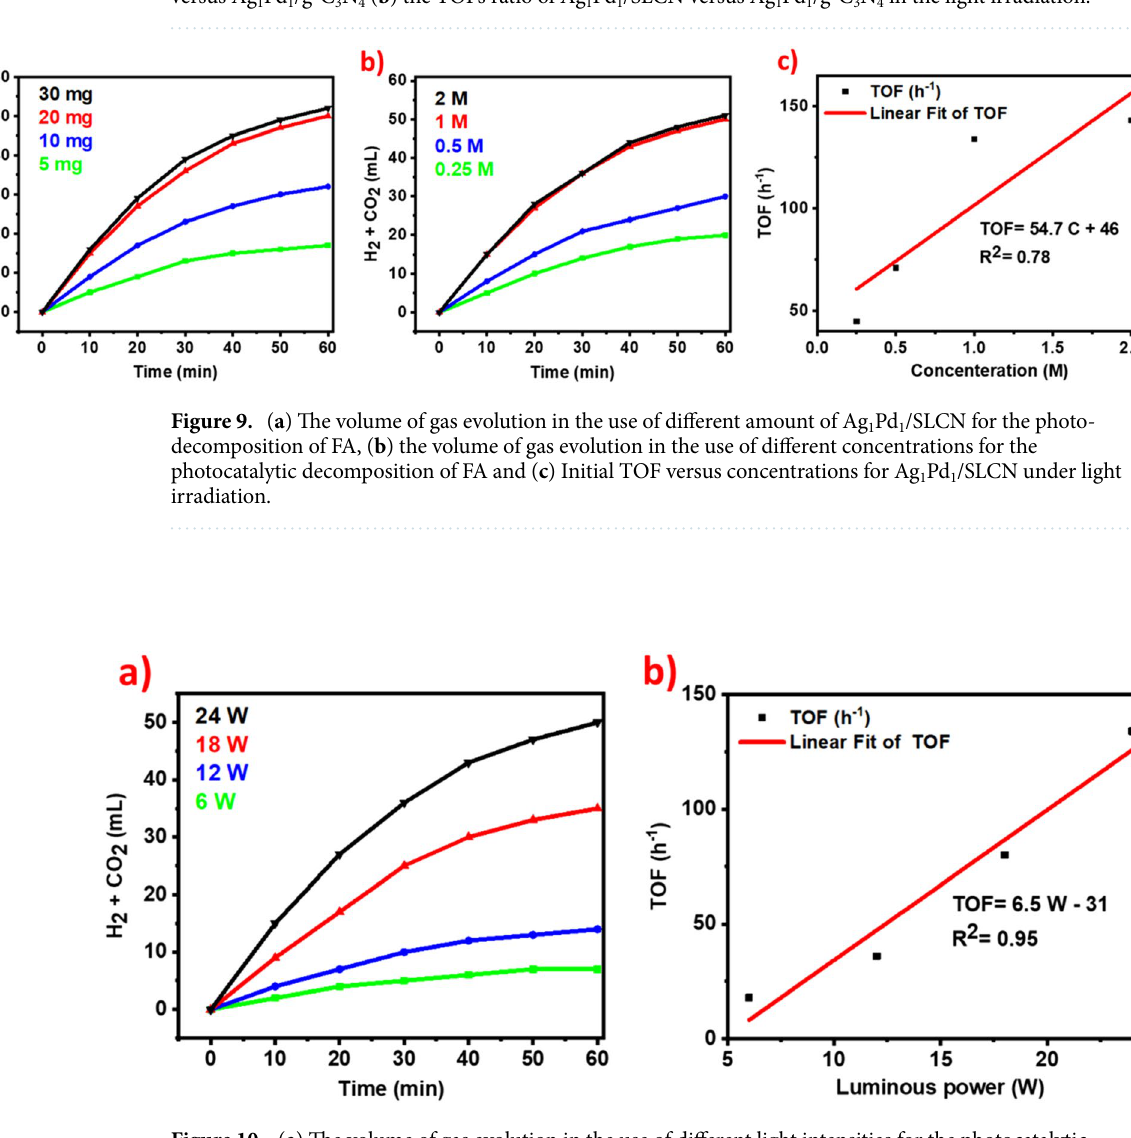
Figure 10. ( a ) The volume of gas evolution in the use of different light intensities for the photocatalytic decomposition of FA and ( b ) Initial TOF versus luminous power for Ag 1 Pd 1 /SLCN under visible light